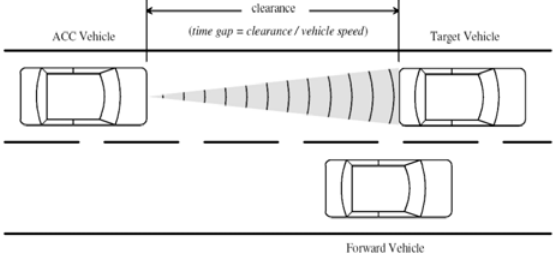
Fig.6. Technical functions of adaptive cruise